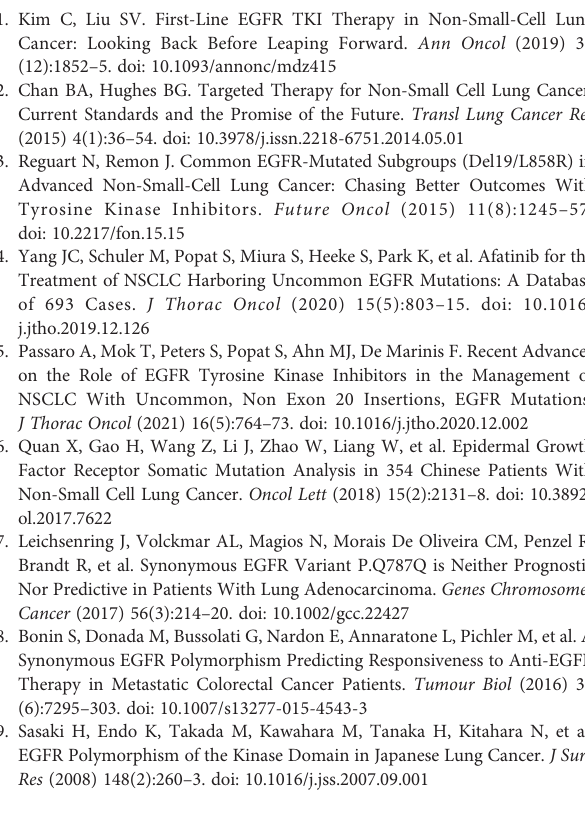
Supplementary Figure 1 | KM curve for patients without EGFR mutation and chemotherapy treatment. Median overall survival: Q787Q (+): 6.70 months (95%CI: 4.75-NA); Q787Q (-): 8.58 months (95% CI: 6.14-13.2). Log rank test p=0.971. Q787Q (+) and Q787Q (-) denoted patients with EGFR Q787Q polymorphism and without EGFR Q787Q polymorphism,